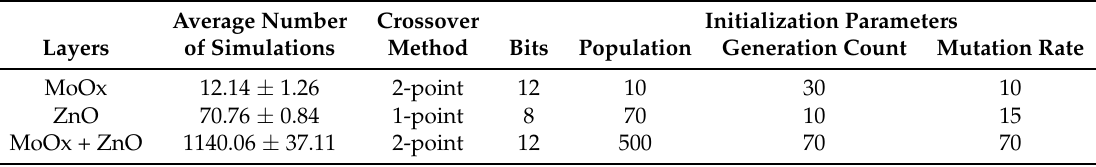
Table 5. Initialization parameters for best